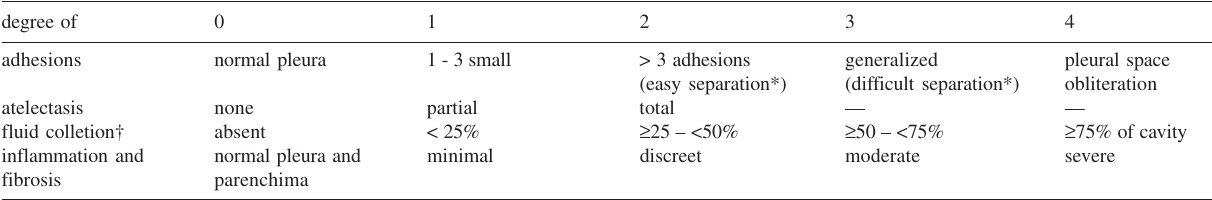
Table 1 - Scoring scheme for the macroscopic and microscopic evaluations of the pleura degree of 0 1